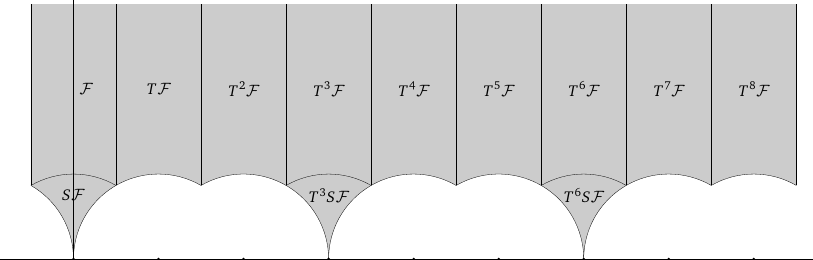
Figure 17: ‘Standard’ fundamental domain for Γ 0 ( 9 ) , with I